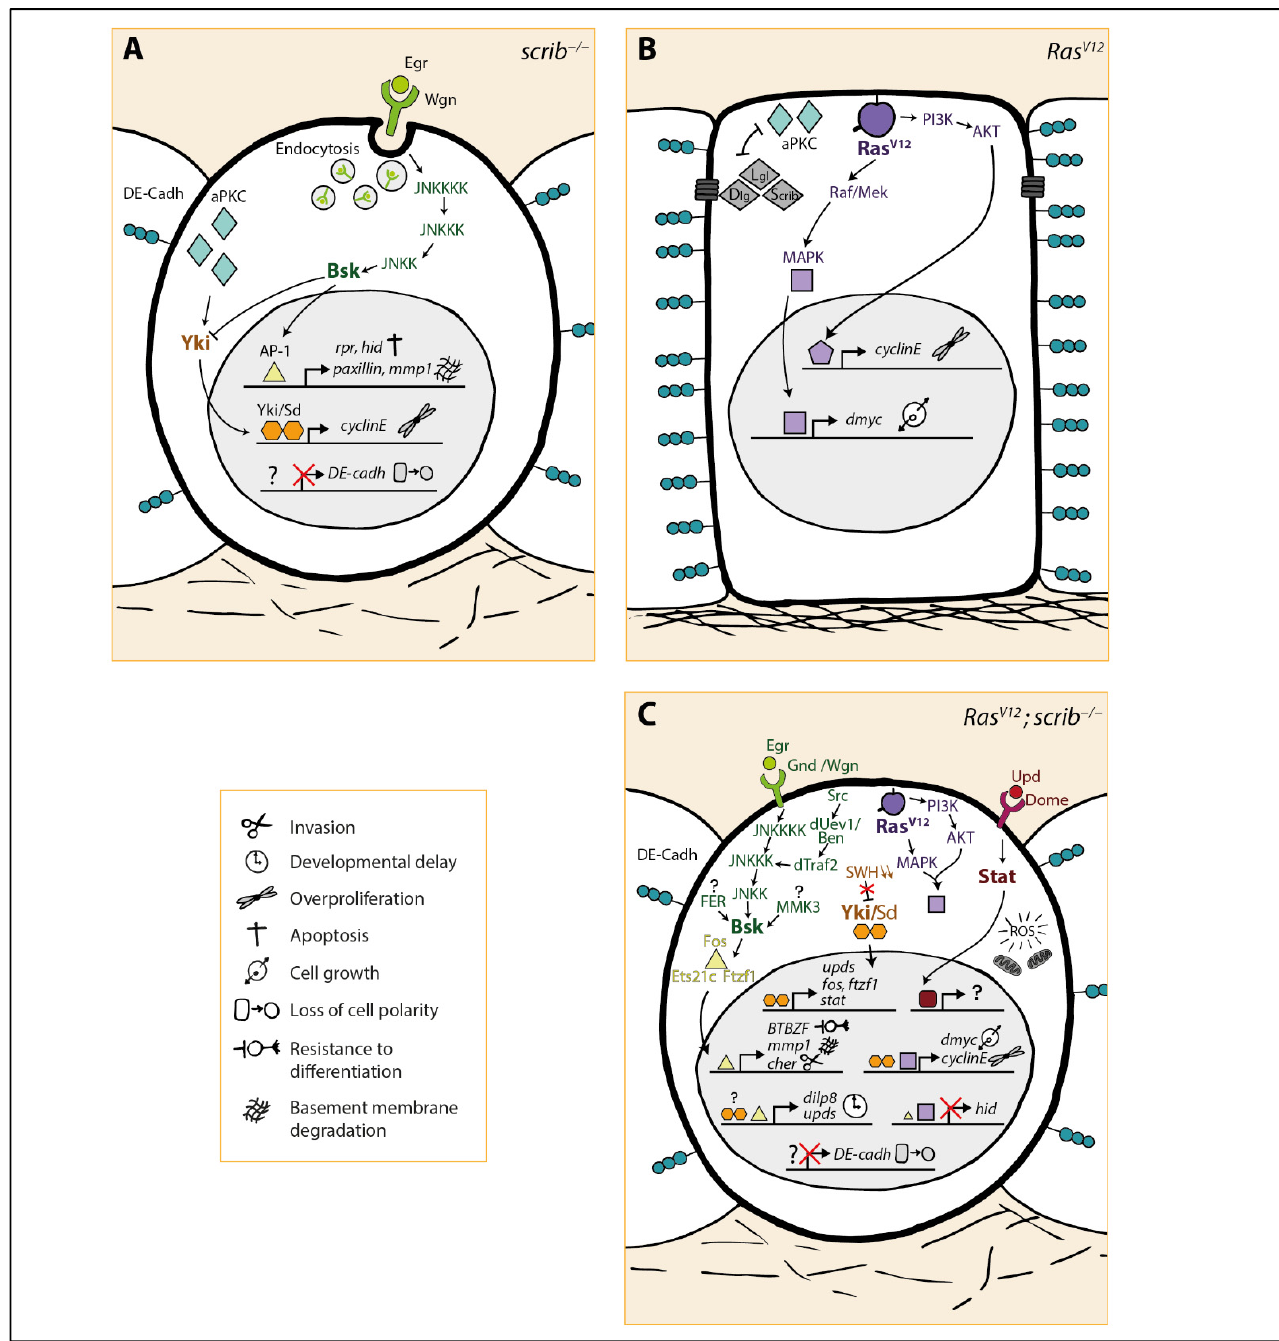
Figure 2. Cooperative oncogenesis results from the atypical interplay of various signaling pathways that display several tumor cancer hallmarks. ( A ) In scrib − / − benign tumors, the JNK pathway (green) has an antitumorigenic function. It is activated by the TNF Eiger, which binds to the TNFR Wengen (Wgn). Elevated endocytosis levels contribute to activating the Eiger/Wgn complex that activates a phosphorylation event cascade involving successively the JNKKKK, JNKKK, and JNKK. Ultimately, the JNK Basket is phosphorylated and activates its downstream AP-1 TFs effectors. AP-1 TFs stimulates the expression of the proapoptotic factors rpr and hid, which execute apoptosis a well as paxillin and mmp1, which leads to basement membrane degradation. Simultaneously, the loss of cell polarity initiated by the loss of function of scribble provokes aPKC (blue) signaling impairment, which results in the activation of the SWH target Yki (orange). Yki together with Sd activates the expression of cyclinE and causes overproliferation. Finally, DE-cadherin expression decreases, con- tributing further to the loss of cell polarity phenotype. ( B ) In Ras V12 hyperplastic tumors, the Scrib (grey) and aPKC (blue) apical complexes usually are localized close to the adherens junction and in the apical part, respectively. The aberrantly